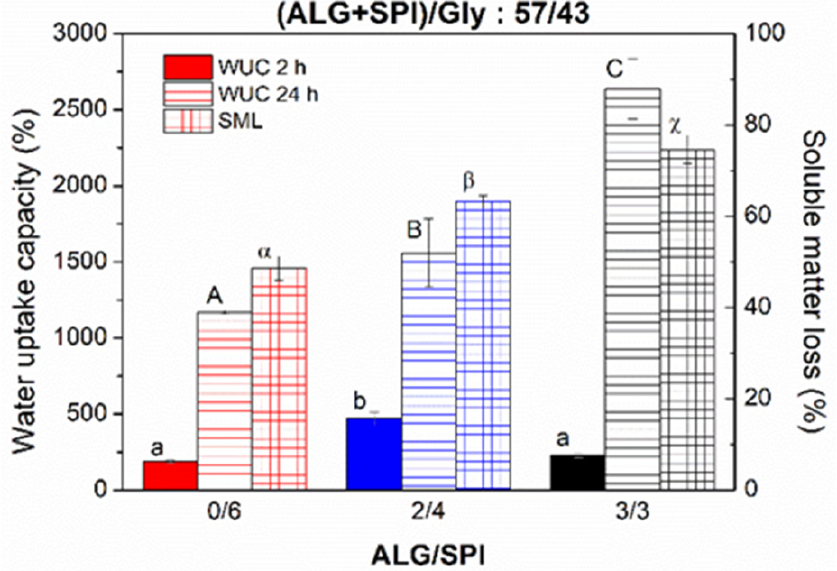
Figure 6. Water uptake capacity after water immersion for 2 and 24 h and soluble matter loss of alginate + soy protein isolate/glycerol composites with ALG/SPI ratios: 0/6, 2/4, and 3/3, maintaining the ALG/SPI/Gly ratio: 57/43. Lower-case, upper-case, and Greek letters indicate that average values are statistically different ( p < 0.05).